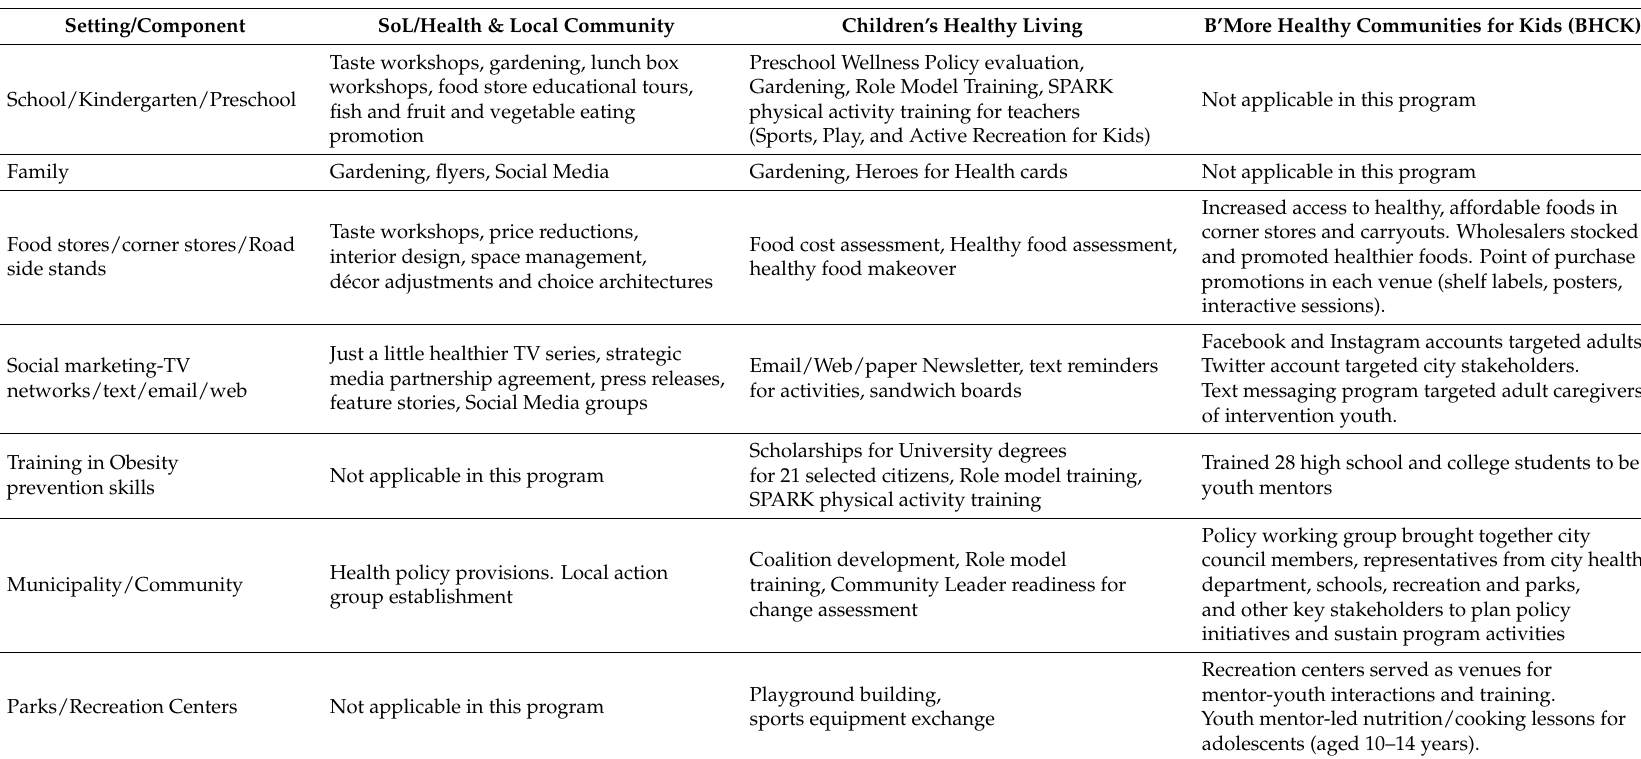
Table 1. Multilevel-Multicomponent (ML-MC) intervention components. The table shows the components of the three ML-MC community-based interventions.